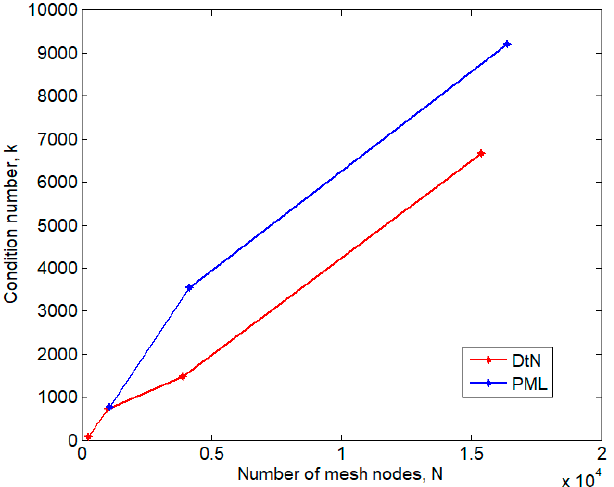
Figure 7. Case study 3 (cable bundle with dielectric). Condition number of the stiffness matrices associated to the two numerical solutions versus the number of mesh nodes.